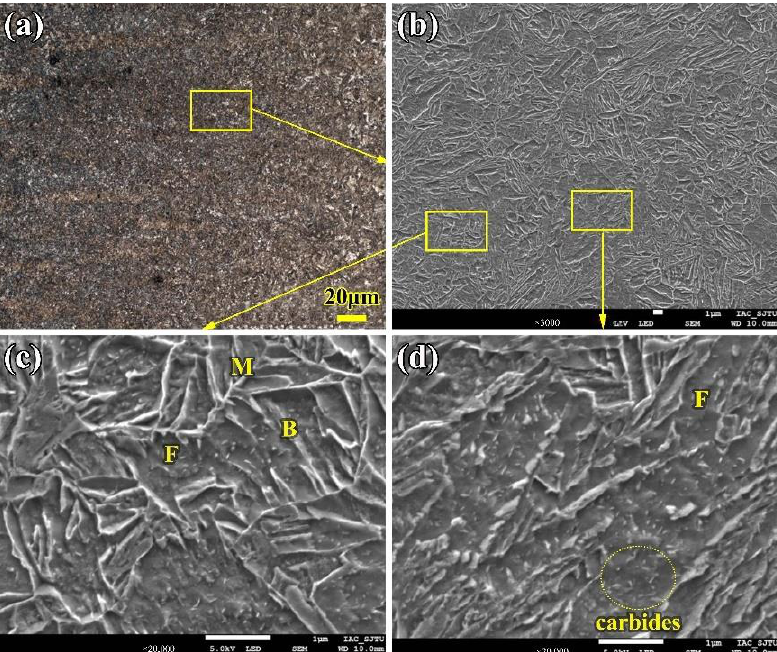
Figure 5. Microstructure of the FGHAZ of the LBW joint ( a ) Macro-photo of the FGHAZ ( b ) Micro- photo of the FGHAZ ( c ) Ferrite and bainite ( d ) Carbides in the FGHAZ. F:ferrite; M:martensite; B: bainite.